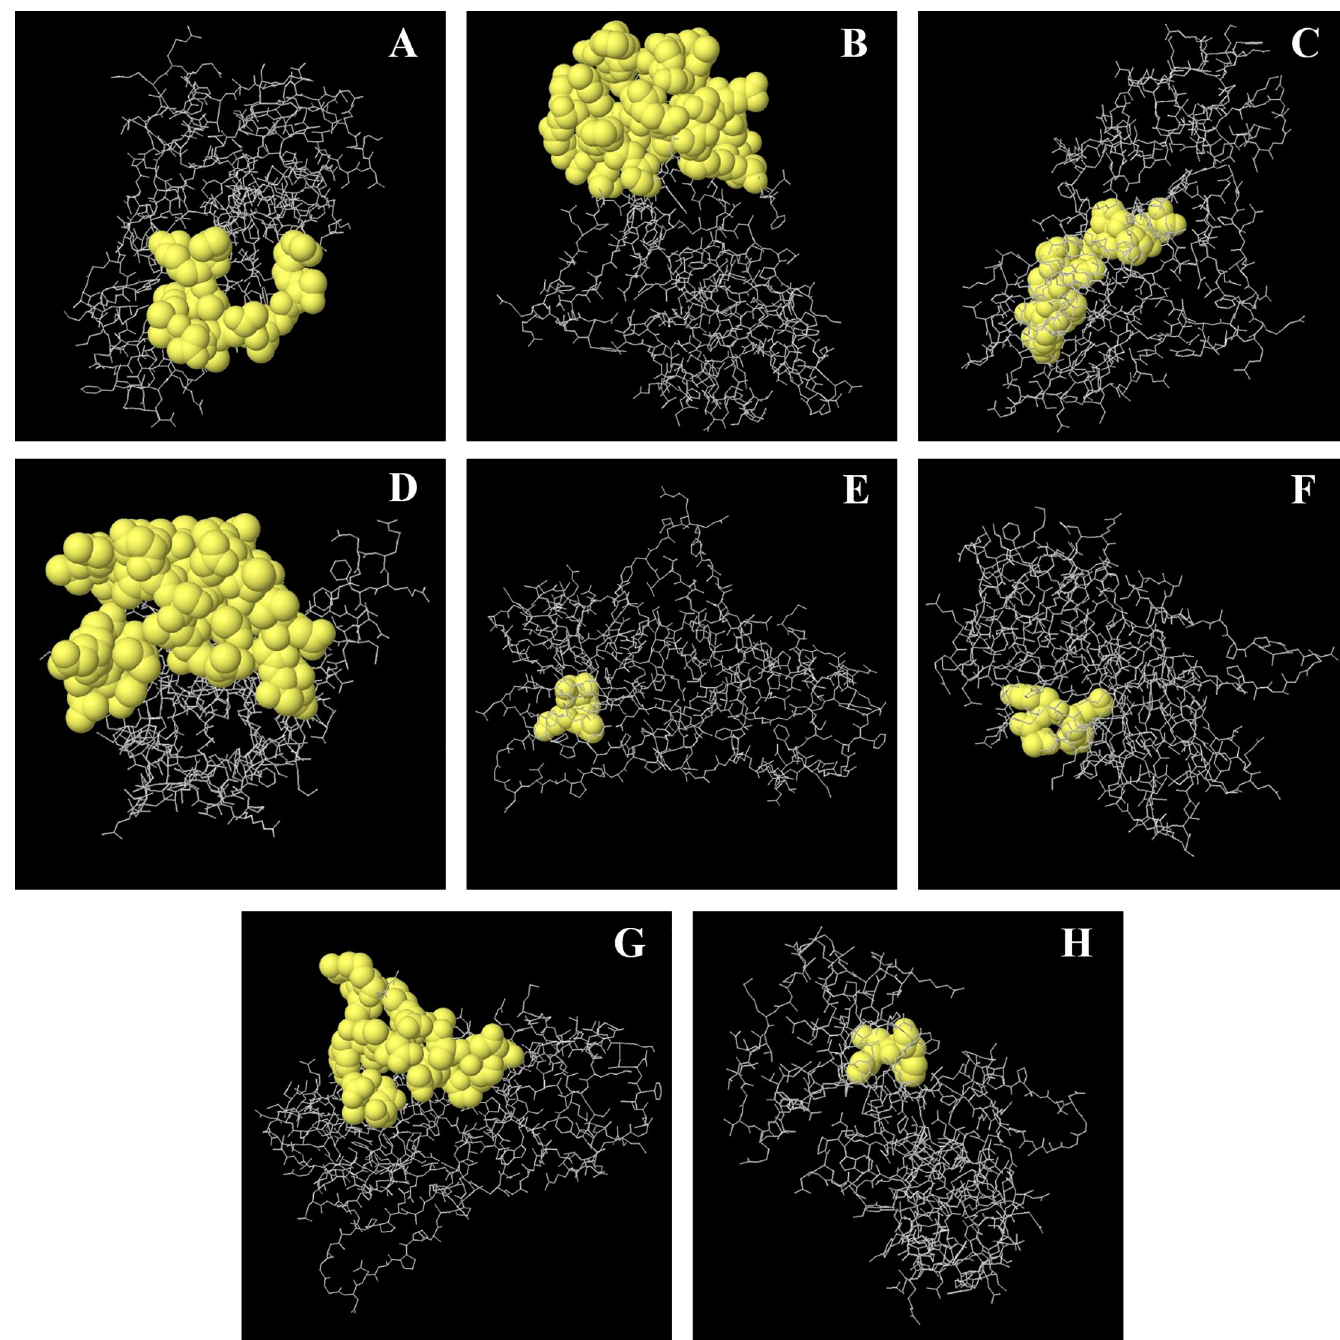
Fig 6. Conformational or discontinuous B cell epitopes of WP_005413200.1 predicted from the PDB structure (homology). Here, A-H, the yellow balls represent the residues of the corresponding epitopes, and sticks in white color are the structure of the core residues.